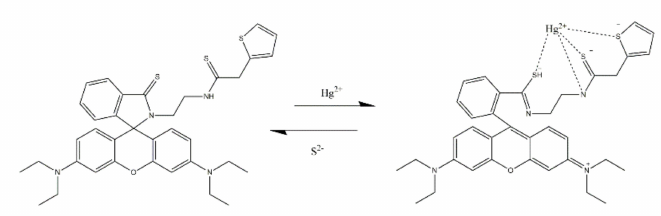
Figure 4. The proposed sensing mechanism of RBST (Table 1, No. 5) to Hg 2+ [37]. Dewangan S., et al. synthesized a significant molecule through the functioning of the cymantrenyl hydrazone system by fluorescent tagging of rhodamine (Table 1, No. 6) [38]. The synthesized molecule displayed high selectivity and responsiveness to Hg 2+ (Figure 5). The prepared sensor was applied to recognize Hg 2+ in bacterial strains and THP-1 cancer cells, indicating its potential in bioimaging applications.